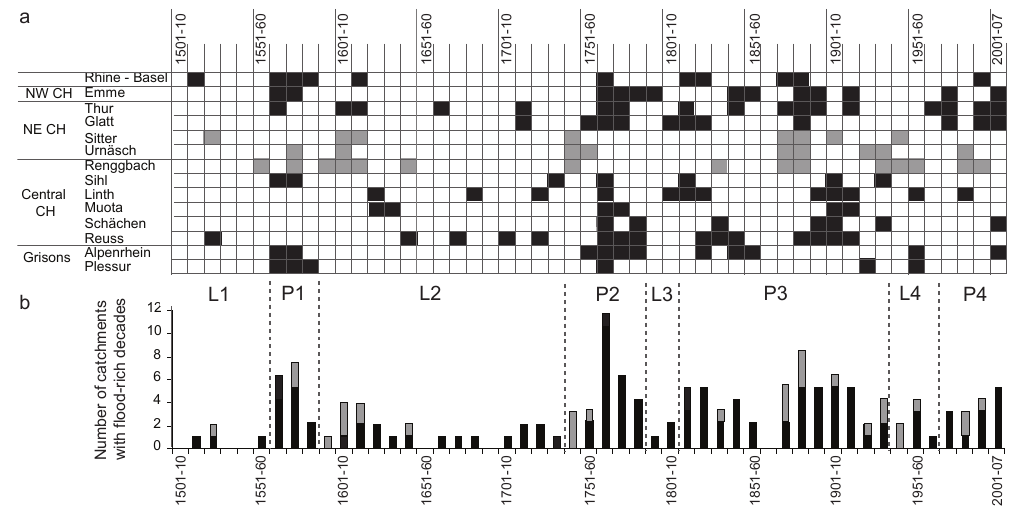
Fig. 6. Flood-rich decades in our 14 catchments (black: flood-rich decade in large catchments caused by long duration rainfall events, grey: small catchments where convective rainfall events are important). Also shown are the periods rich (P1–P4) and poor (L1–L4) in floods in northern Switzerland, as defined in this study (vertical dotted